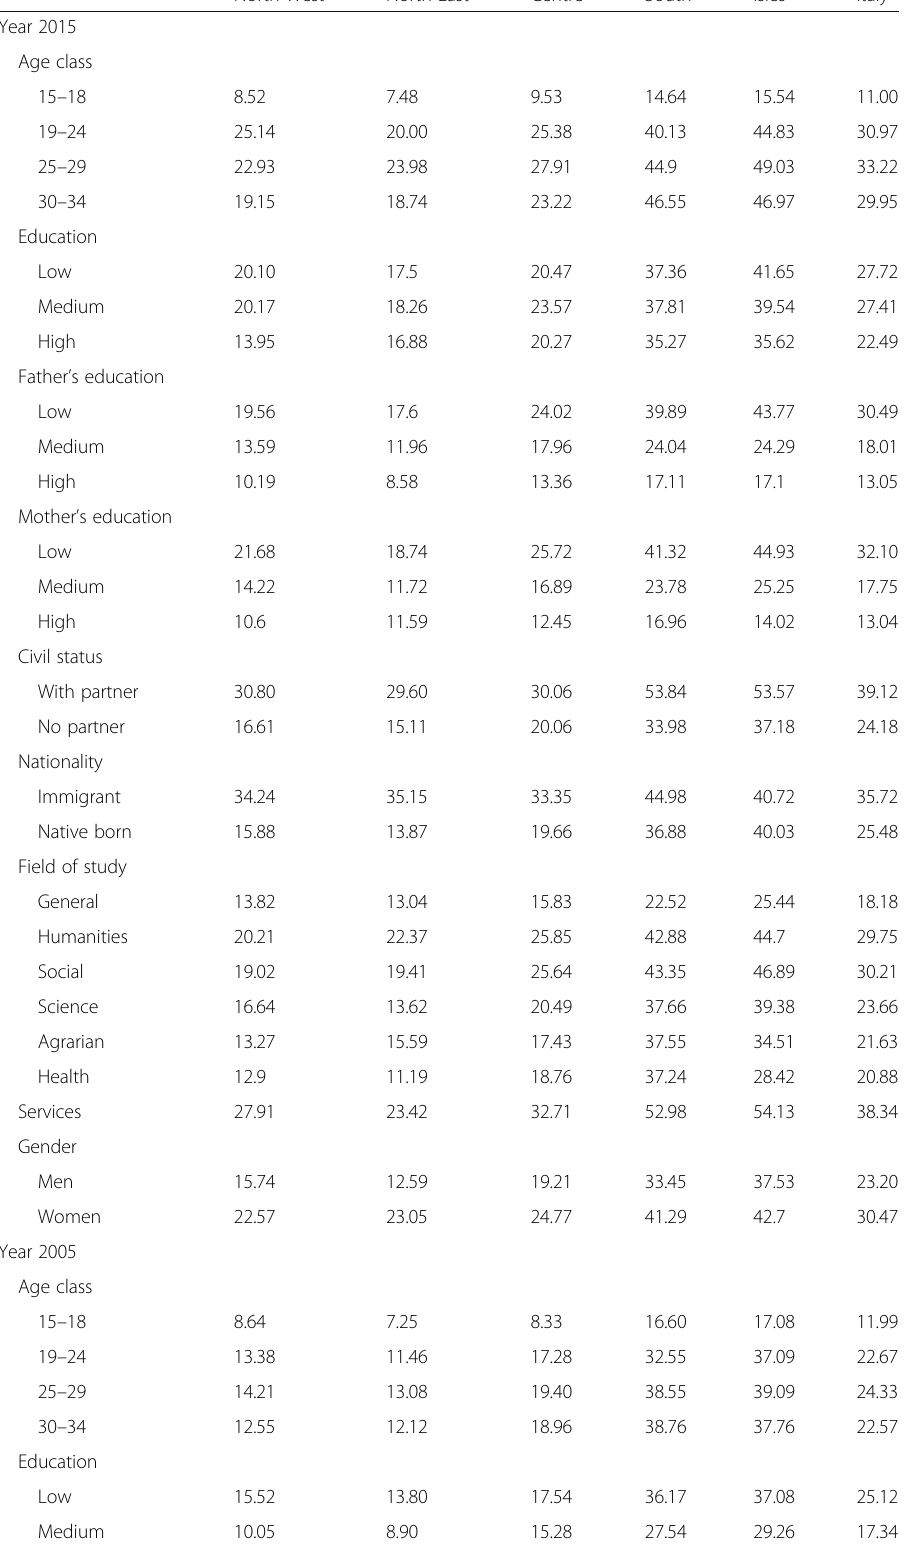
Table 1 Share of NEETs in the Italian macro-regions according to some personal characteristics (*) North-West North-East Centre South Isles